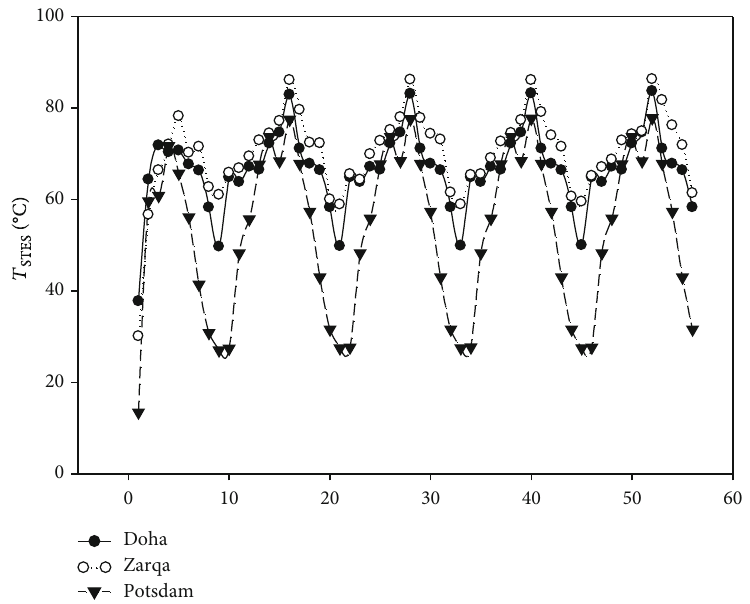
Figure 9: STES temperatures along the simulations ’ fi ve-year span in the three selected